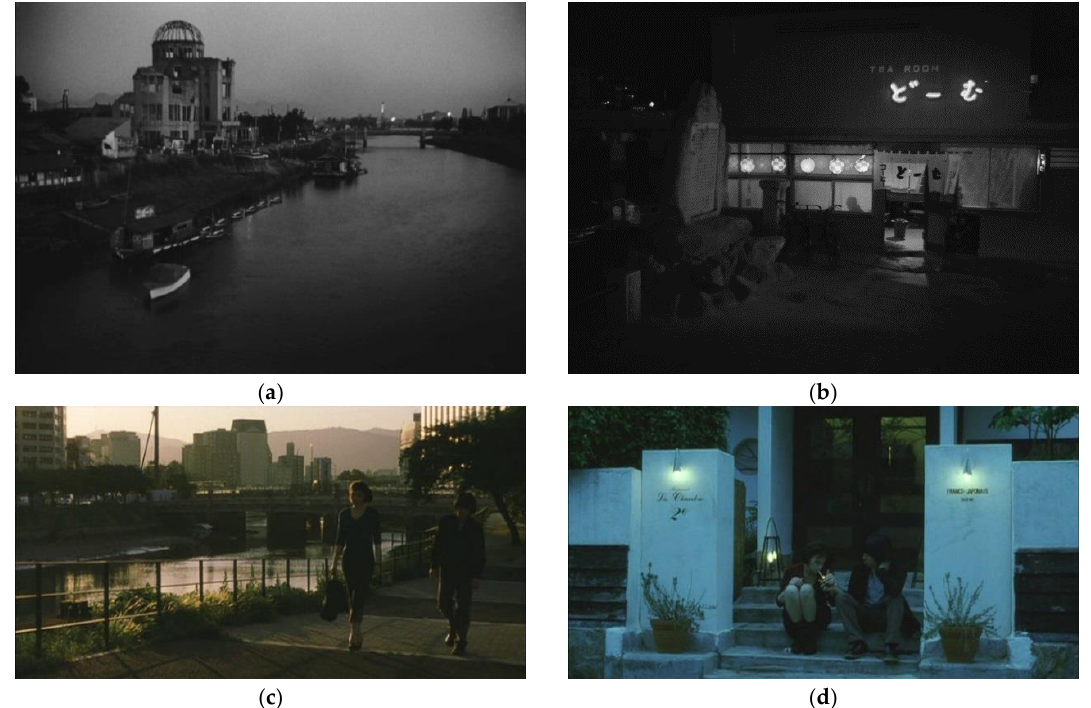
Figure 2. Frames showing similar sets in Hiroshima mon amour and H Story : the Ota River ( a,c ) and the restaurants ( b,d ) where a key scene takes place in both films. Source: DVD editions by Acontracorriente (Spain) and Cinéma Indépendant (France).